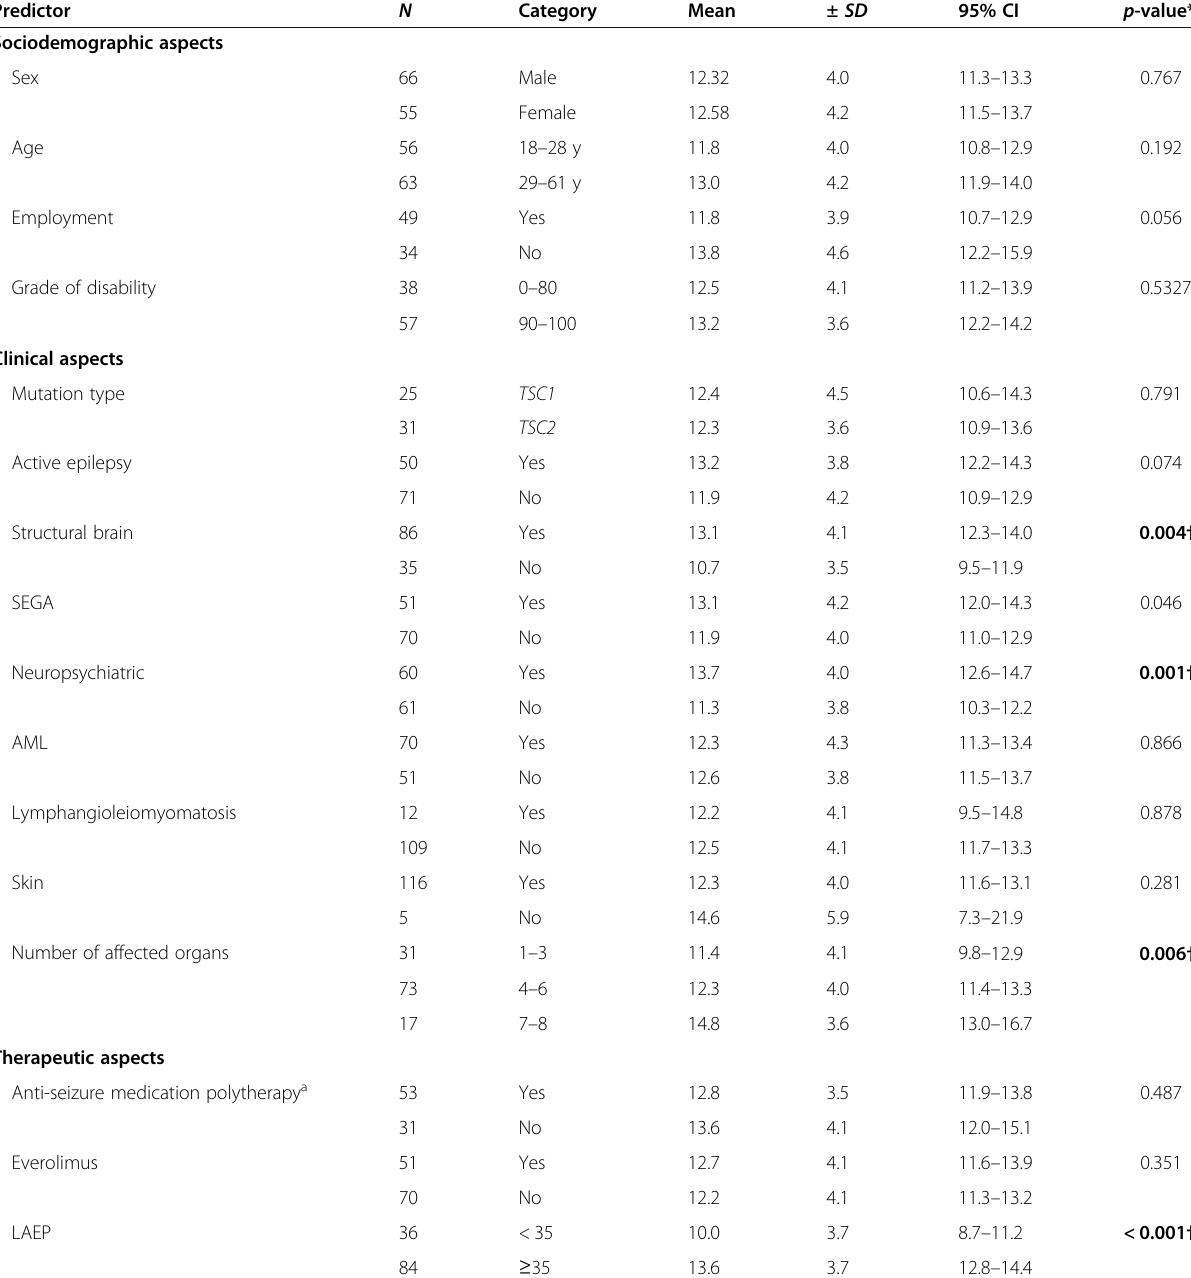
Table 4 Comparisons of mood among individuals with TSC, as measured by the NDDI-E (German version) questionnaire, according to several potential predictors and assessed using Kruskal – Wallis and Chi-square tests